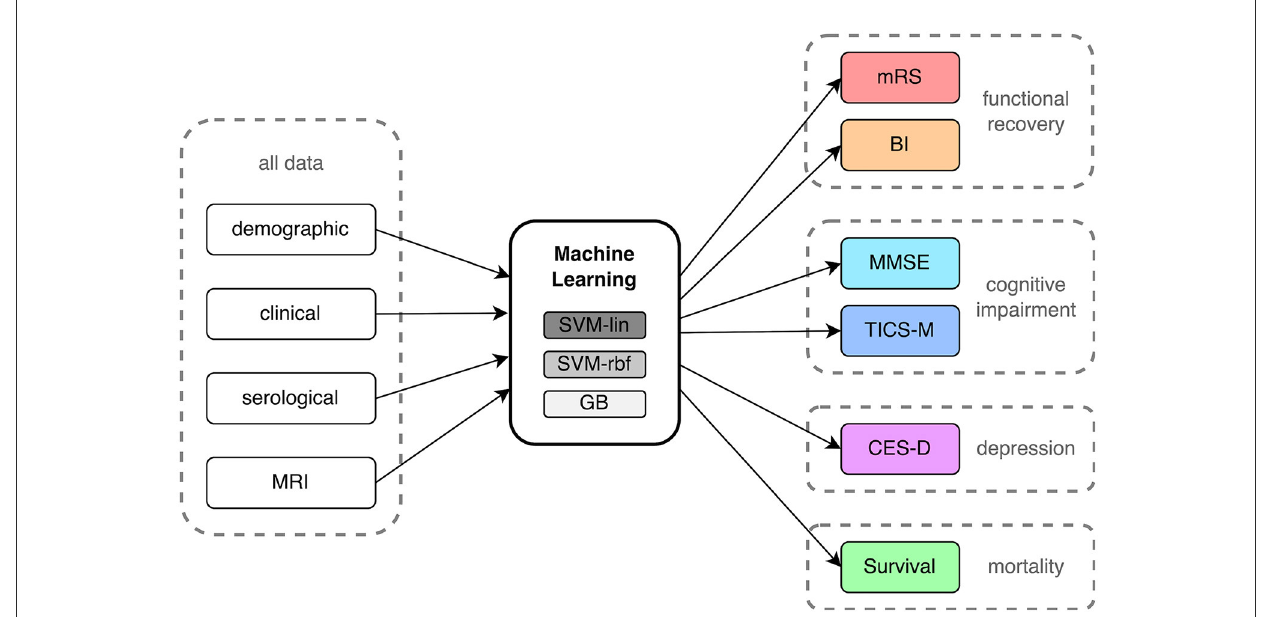
FIGURE2 Process flow of input data, machine learning analysis and outcome prediction. mRS, modified Rankin Scale; BI, Barthel Index; MMSE, Mini-Mental State Examination; TICS-M, Modified Telephone Interview for Cognitive Status; CES-D, Epidemiologic Studies Depression Scale; SVM-lin, Support Vector Machine with linear kernel; SVM-rbf, Support Vector Machine with radial basis function kernel; GB, Gradient Bossting Classifier; MRI, Magnetic resonance